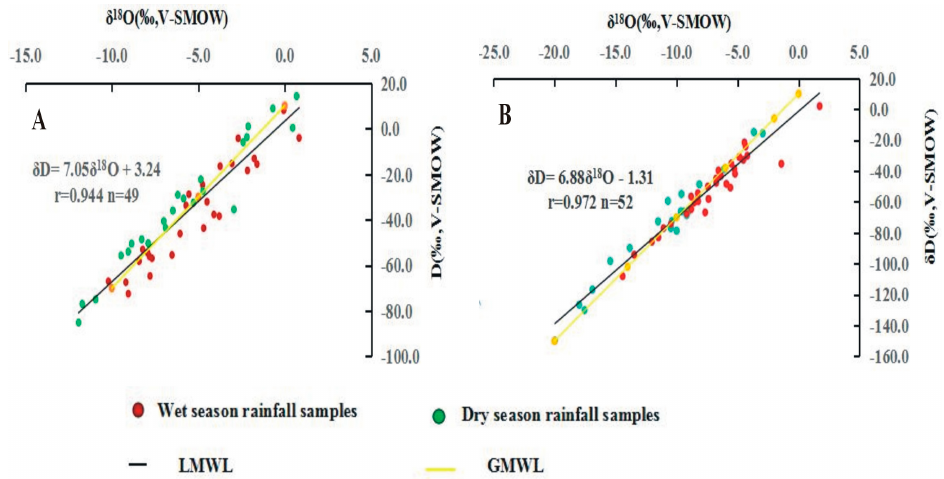
Figure 3. Distribution of δ D and δ 18 O of precipitation. ( A , B ) represent Fengxiang and Ningwu, respectively. LMWL = local meteoric water line; GMWL = global meteoric water line.